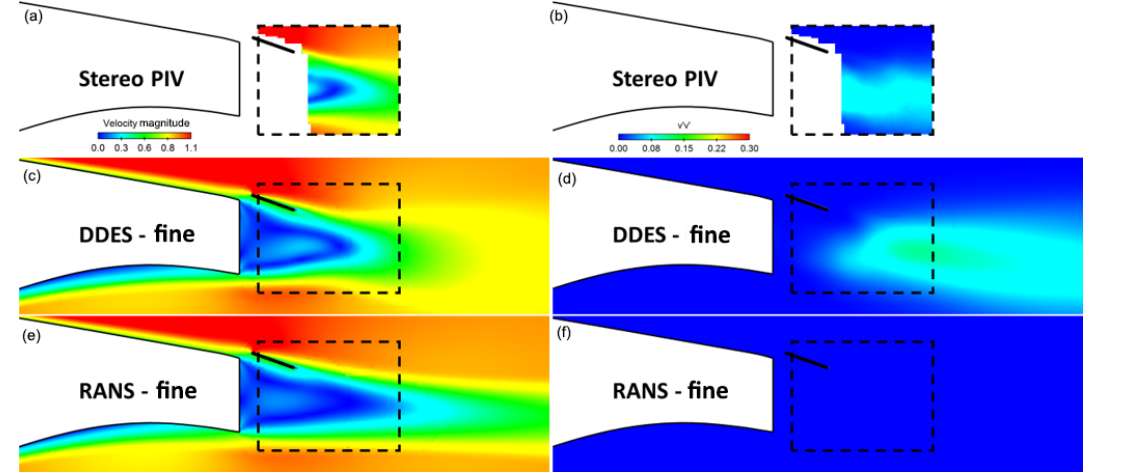
Figure 11. Flap case. Normalised velocity magnitude contours, V/V ∞ , (a, c, e) and v (cid:48) v (cid:48) /V 2 ∞ normal Reynolds stress contours (b, d, f) : comparison between stereo PIV, RANS and IDDES results. The fine mesh (25 million cells) was used in the calculations.